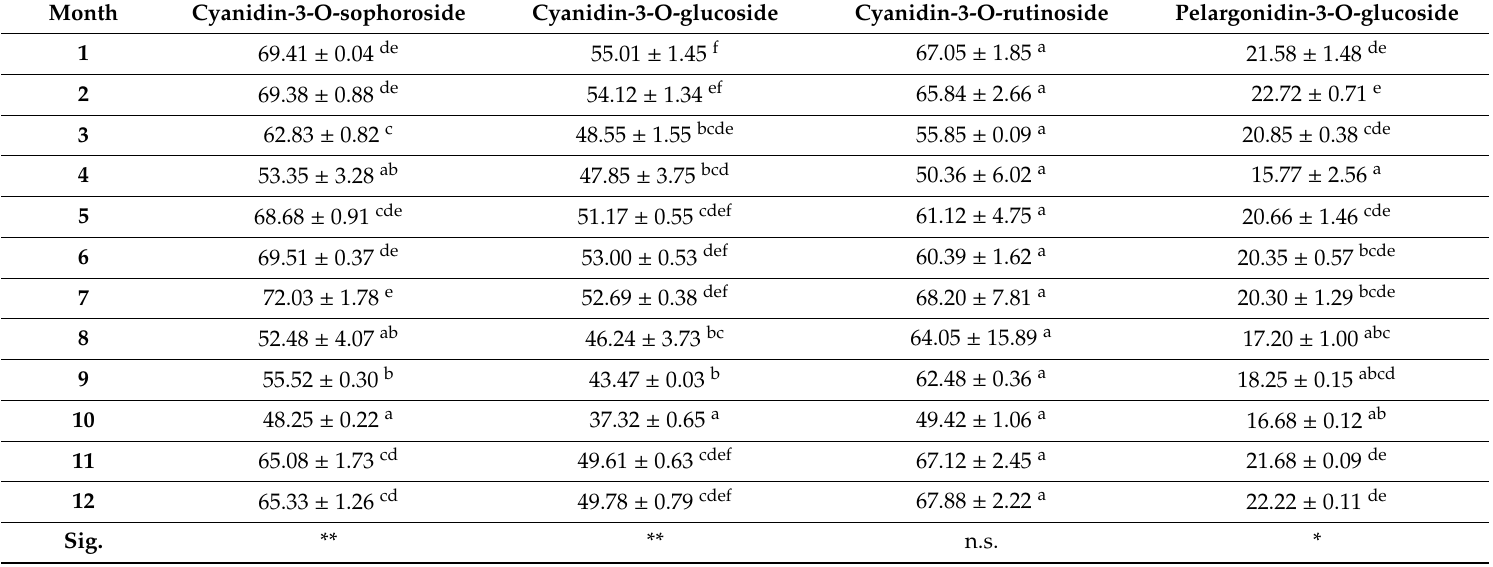
Table 12. Fruits stored at –20 ◦ C in freezer, packaged in Nanoactive A film. E ff ect of storage period on the di ff erent anthocyanidin compounds content in red raspberries (cv. Erika). Results are expressed in µ g / g of fresh weight. The results are the mean of three replicates ± Standard Deviation. ** ( P ≤ 0.01); * ( P ≤